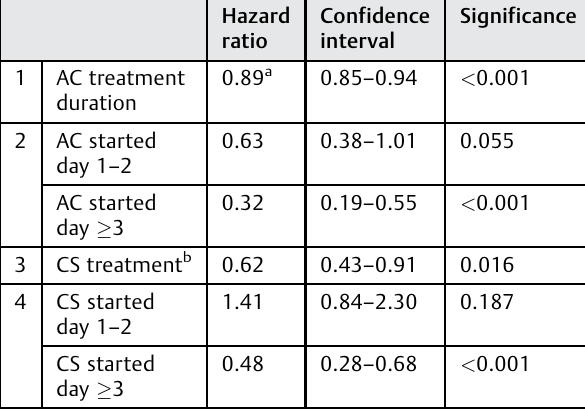
Table 3 Variant multivariate Cox proportional hazards